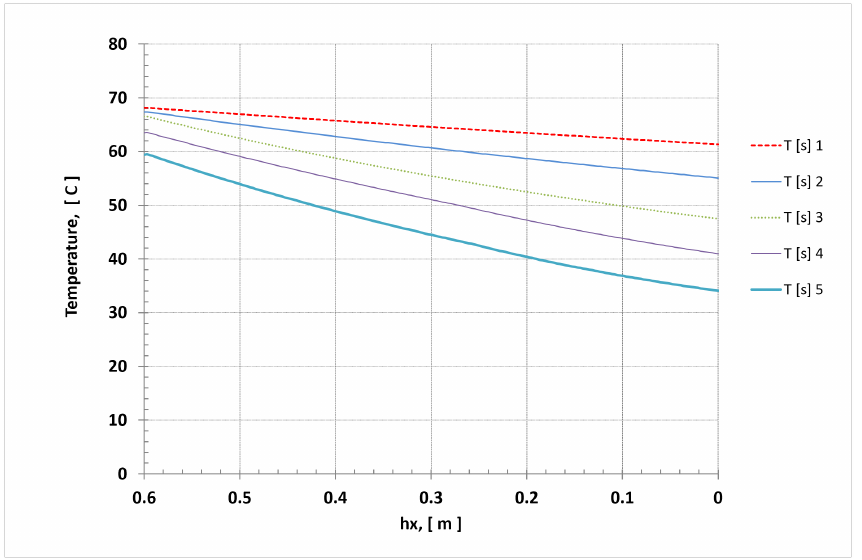
Figure 14. Profile of the radiator surface temperature temperature change, radiator T1. t s = 70.2 ◦ C, qmx from 39% to 356% qmo ( nominal flow rate